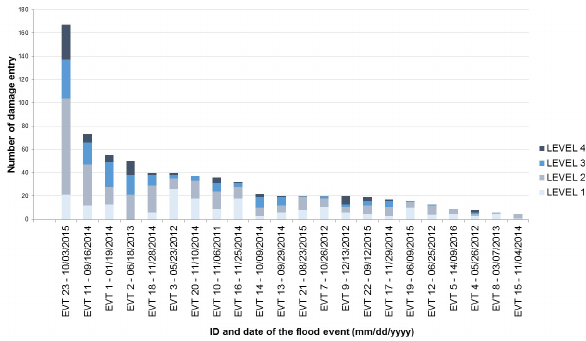
Figure 7. Severity and number of damage entries per flood